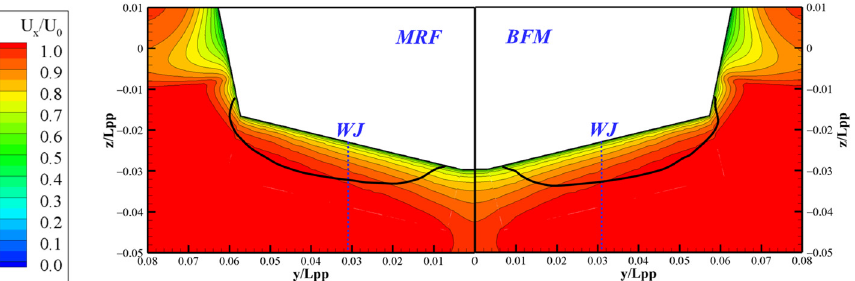
Figure 14. Velocity distributions in the capture area with the MRF model and body-force model (BFM).